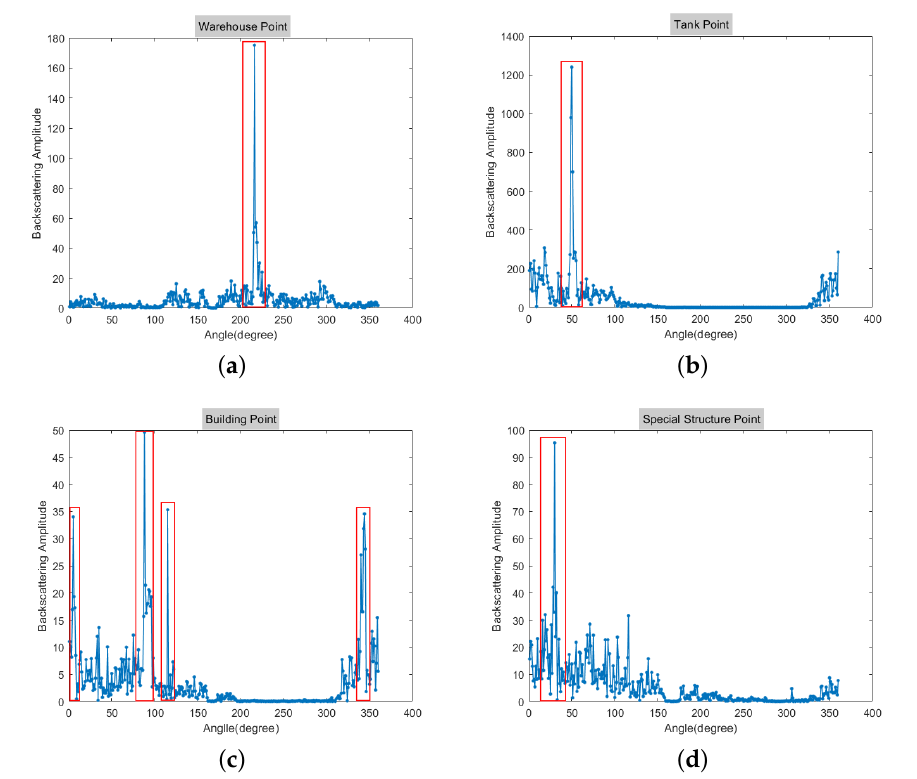
Figure 7. One-dimensional backscattering curve distribution: ( a ) represents backscattering amplitude curve of warehouse point; ( b ) represents backscattering amplitude curve of tank point; ( c ) represents backscattering amplitude curve of building point; ( d ) represents backscattering amplitude curve of special structure